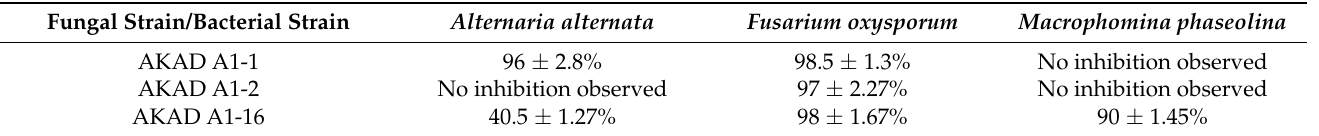
Table 1. Antagonistic activity of the bacterial endophytes as determined by the dual culture plate assay. Fungal Strain/Bacterial Strain